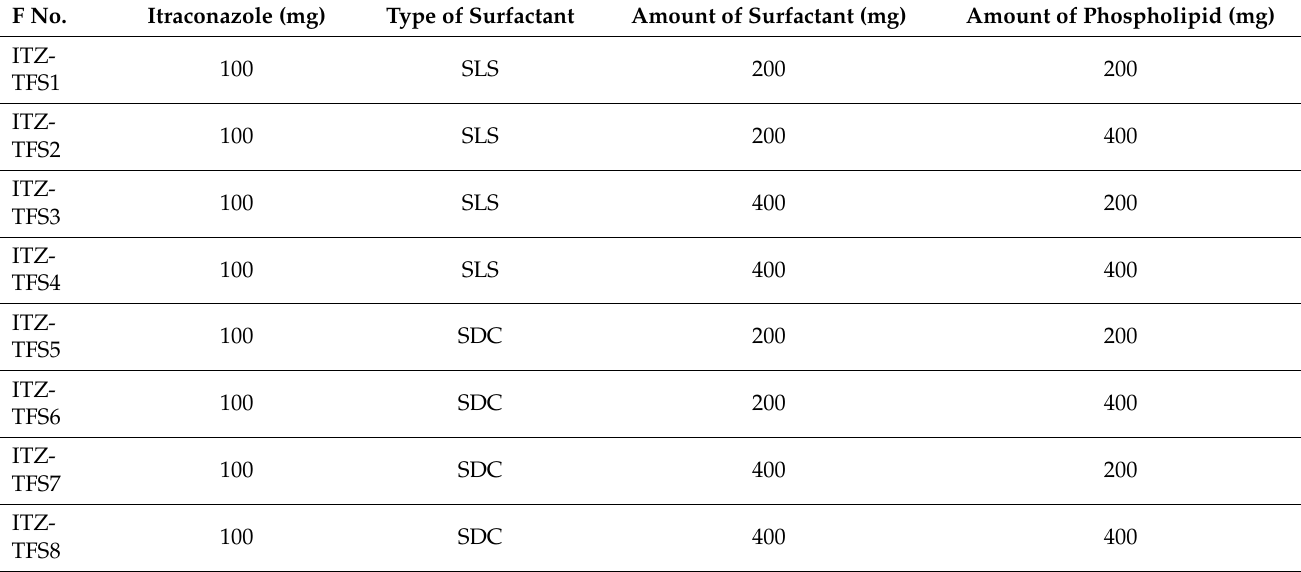
Table 2. The designed ITZ-TFS formulations using 2ˆ3 full factorial design.